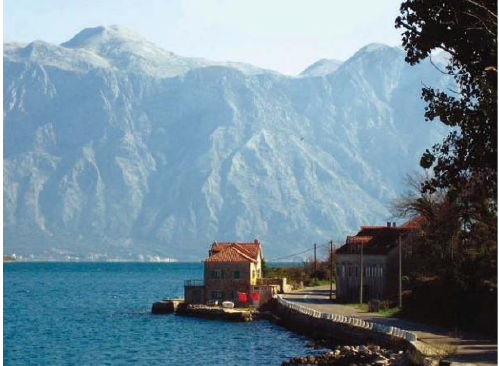
Figure 2. Coastline of Kostanjica- harmony of natural and anthropogenic elements (Source: SAHP)